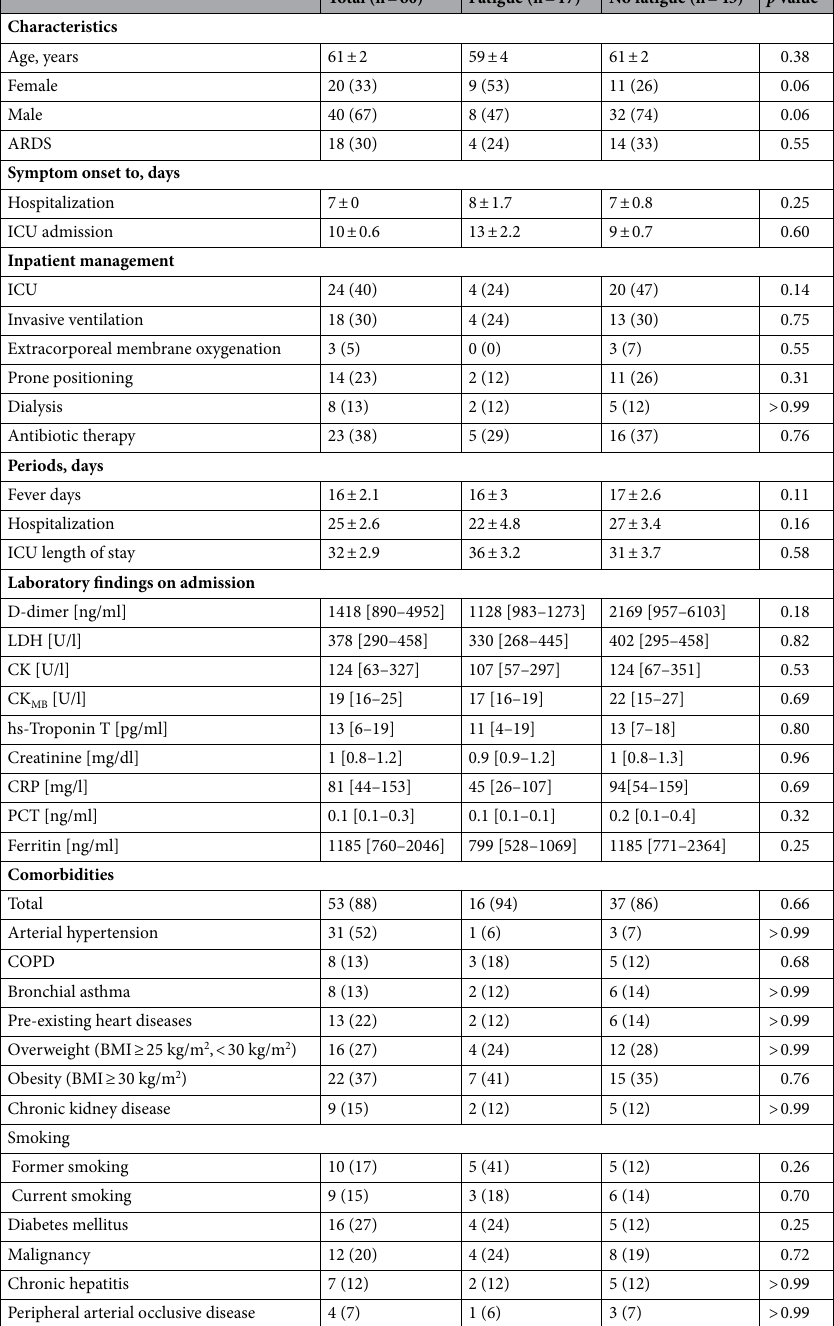
Table 1. Baseline characteristics and comorbidities of the study population. Values are presented as mean ± standard deviation, number of patients (percentage) or median [interquartile range]. ARDS, Acute Respiratory Distress Syndrome; ICU, Intensive Care Unit; LDH, lactate dehydrogenase; CK, creatine kinase; hs-Troponin T, high sensitive troponin-T; CRP, C-reactive protein; PCT, Procalcitonin; COPD, chronic obstructive pulmonary disease; BMI, Body Mass